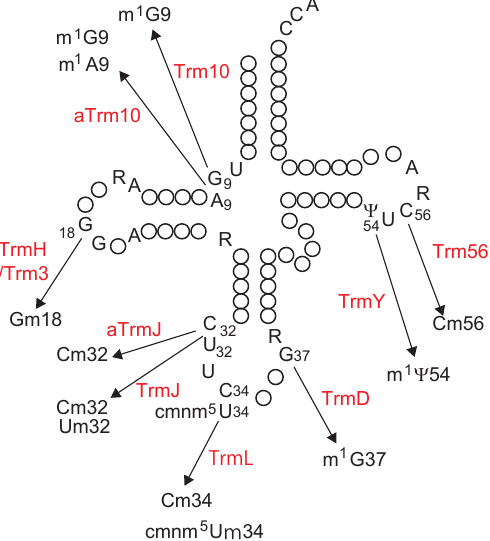
Figure 2. Modification positions in tRNA and the responsible SpoU-TrmD (SPOUT) tRNA methyltransferases. The secondary structure of tRNA is represented in cloverleaf